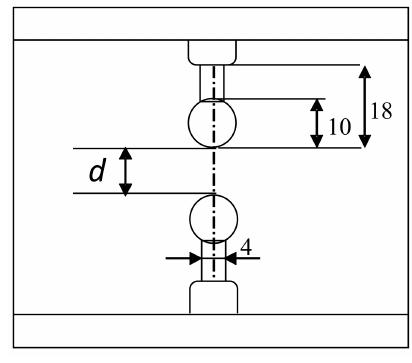
Figure 7. Scheme of the electrode geometry; the dimensions are in mm; d = 10